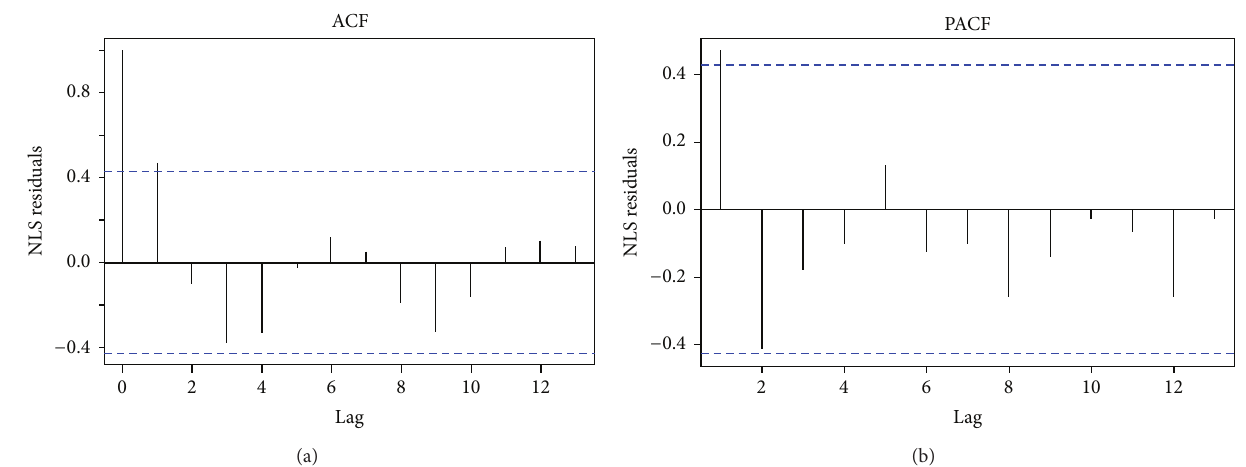
Figure 3: Autocorrelation function (a) and partial autocorrelation function (b) of NLS residuals.